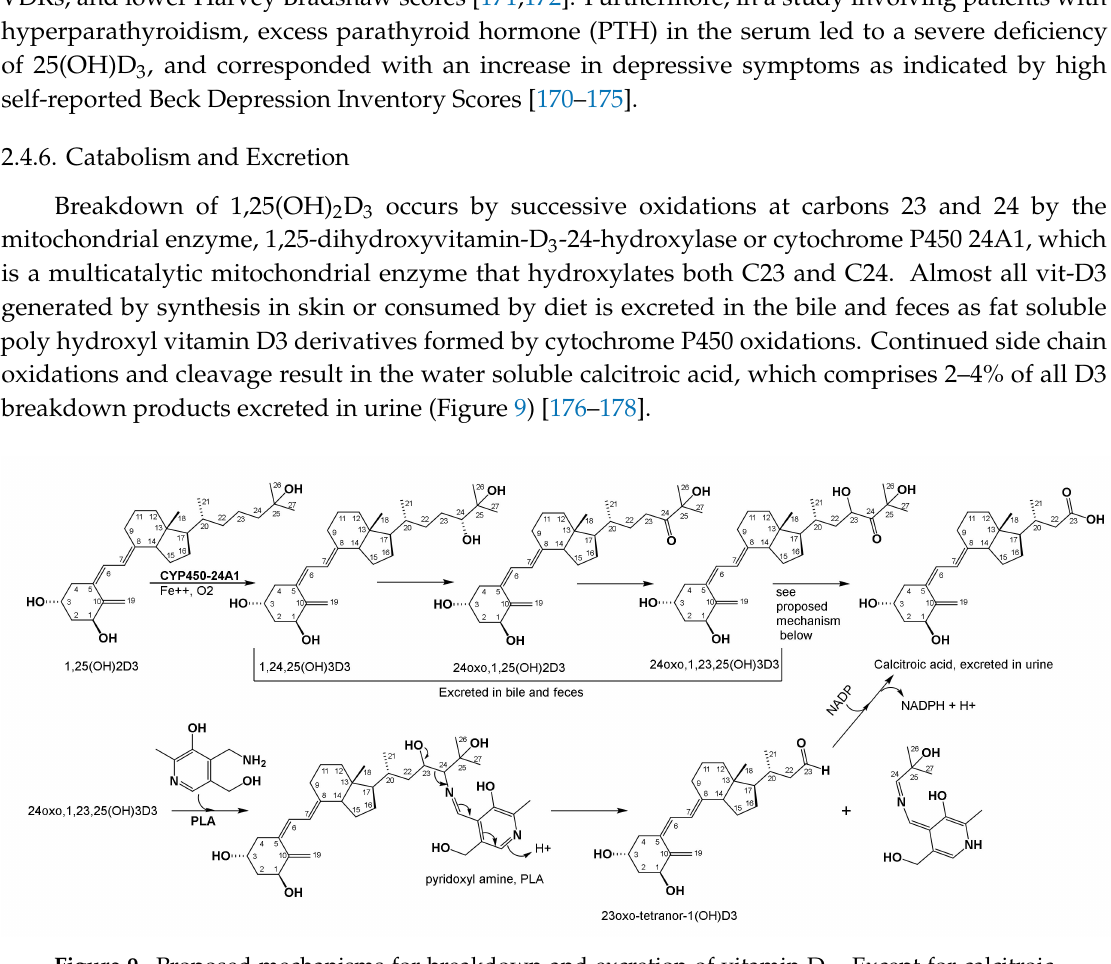
Figure 9. Proposed mechanisms for breakdown and excretion of vitamin D 3 . Except for calcitroic acid which is excreted in urine, all other poly-hydroxy-vitamin-D 3 derivatives, [1,25(OH) 2 D 3 , 1,24,25(OH) 2 D 3 , 24oxo,1,25(OH) 2 D 3 , and 1,23,25(OH) 2 D 3 ] are excreted in bile [176–178]. Cleavage of the side chain at C23 is proposed to involve pyridoxyl amine,